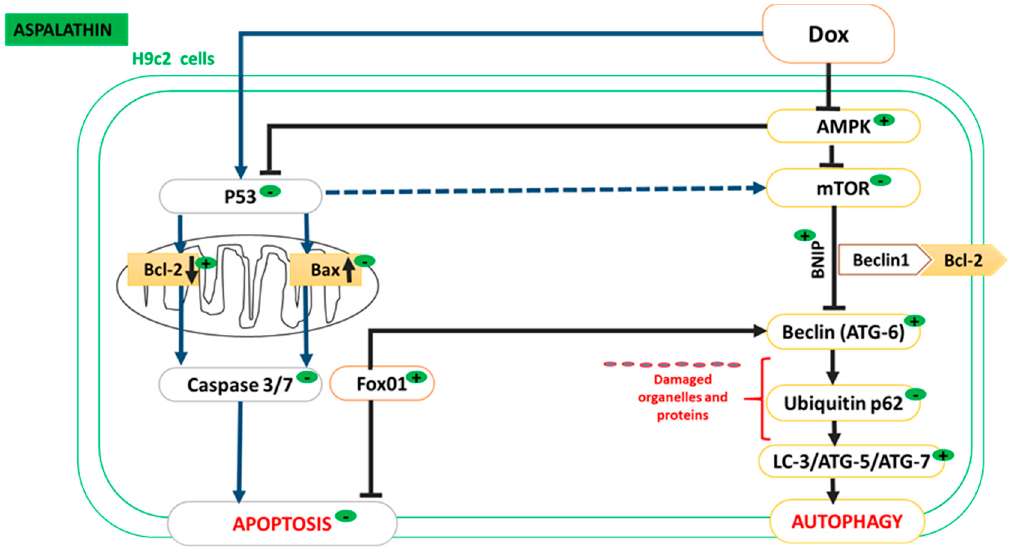
Figure 7. Aspalathin inhibits apoptosis and increase autophagy in H9c2 cells exposed to Doxorubicin (Dox). AMPK is a master regulator known to play an important role in energy homeostasis. Activation of AMPK attenuates Dox-induced activation of mTOR, restoring autophagy flux in H9c2 cells. Chronic exposure to Dox induces apoptosis through increased p53 and caspase-3/7 activity, a process known to be associated with cardiomyocyte loss. Activation of AMPK was able to inhibit p53 expression and enhances cardiomyocyte survival. AMPK, adenosine monophosphate-activated protein kinase ; Bax, Bcl-2-like protein 4; Bcl-2, B-cell lymphoma-2; ATG, autophagy-related genes; Cyt c, cytochrome C; mTOR, Mammalian target of rapamycin; LC3, Microtubule-associated protein 1A/1B-light chain 3 (LC3); P62, Nucleoporin p62.